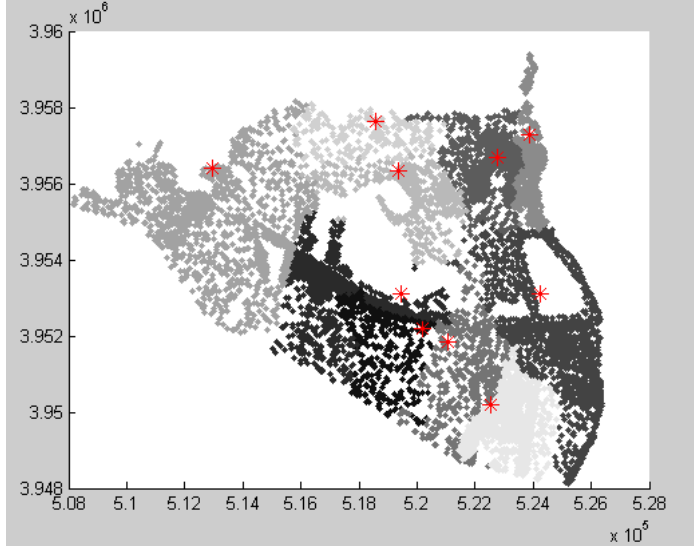
Figure 4. The allocation of each station using the Tabu Search algorithm.